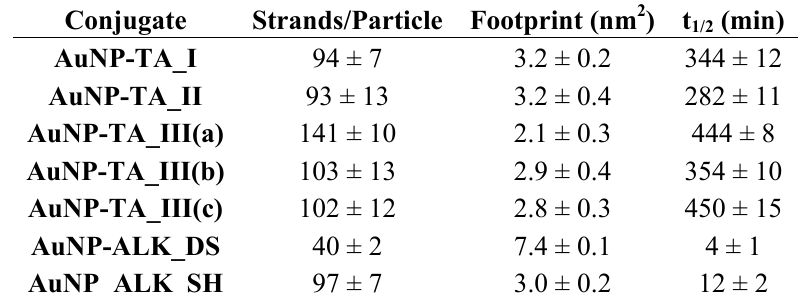
Table 1. Surface coverage and half-lives data for oligonucleotide-gold nanoparticle